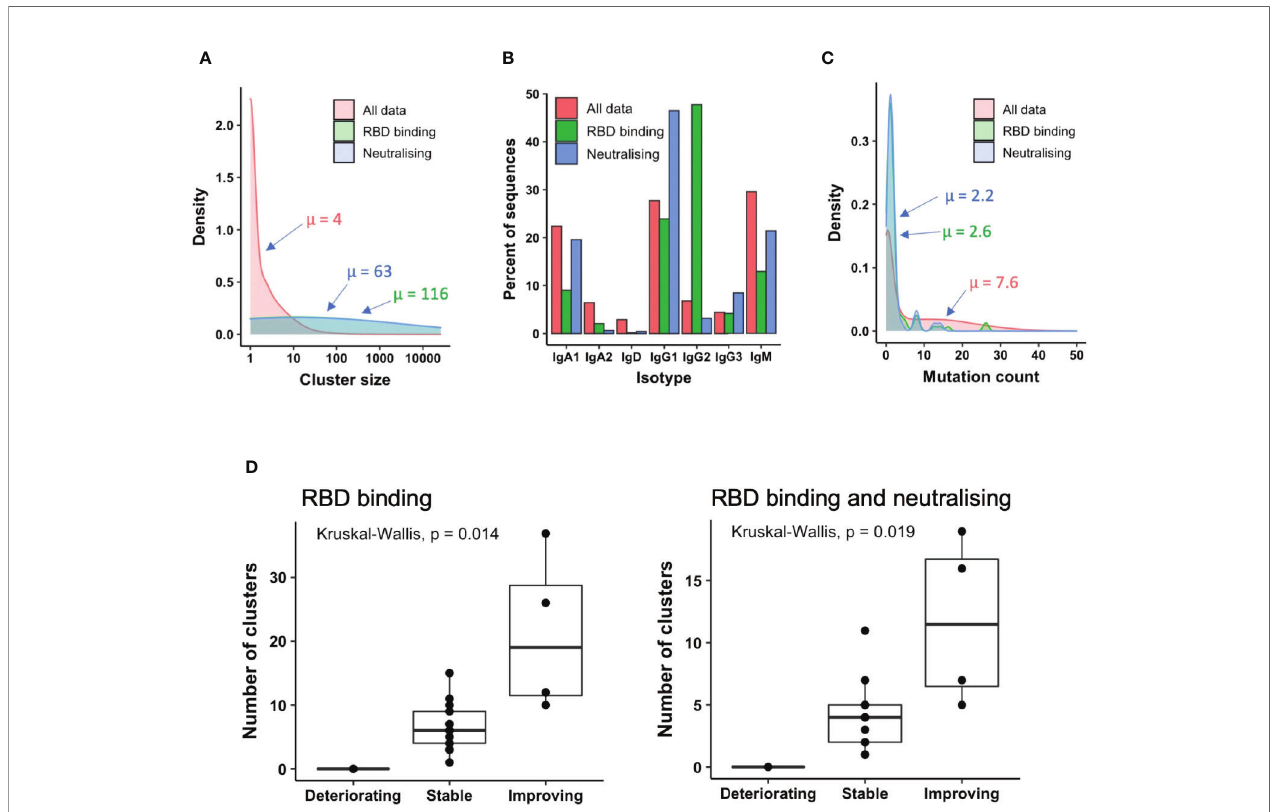
FIGURE 5 | Relating antibodies discovered by phage display back to patient B cell repertoire data. (A) Sequences clustered into related groups. Clusters then annotated based on whether they contained RBD-binding or its subset of neutralizing antibody sequences. Density plot shows distribution of clusters of different sizes in the combined dataset from all 18 patients. (B) The isotype subclass distribution of sequences belonging to the different groups of clusters. (C) Mean mutation of all sequences within each cluster was calculated. Density plot shows the distribution of clusters with different numbers of mutations. (D) The box plot shows the number of clusters annotated as RBD binding (left), or RBD binding and neutralizing (right) in each patient, strati fi ed according to disease